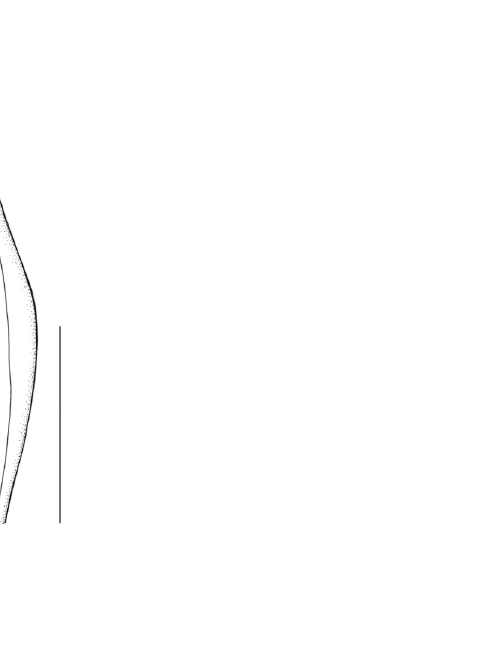
Figure 4. Floral parts of Schiedeella bajaverapacensis: ( A ) floral bract; ( B ) flower—side view; ( C ) Lip. Scale bars—5 mm. Drawn from the holotype by A. Król.